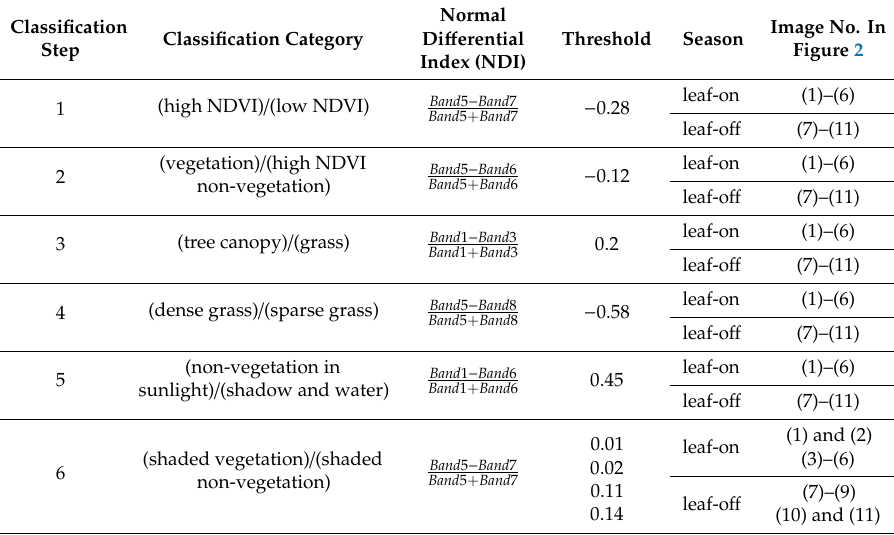
Table 3. Band combinations and threshold variables determined for image